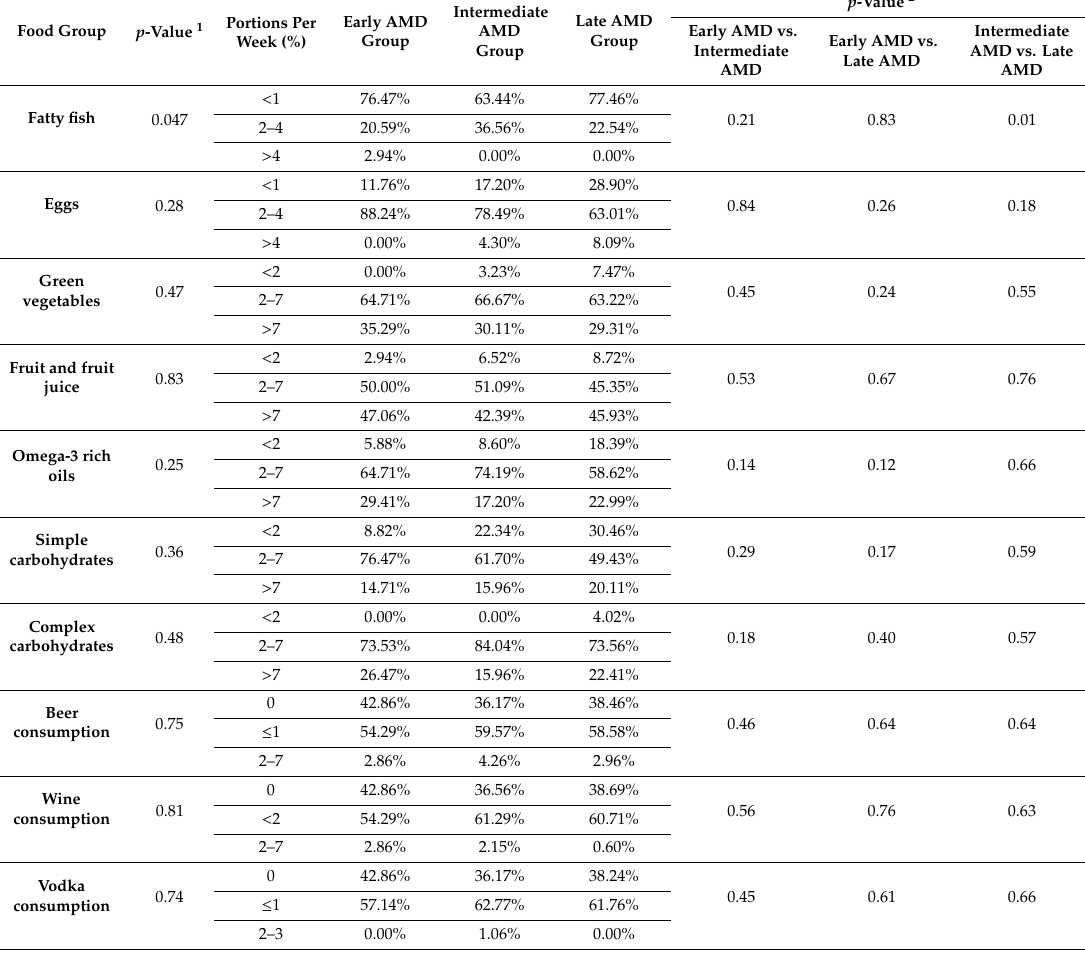
Table 3. Dietary habits of the early, intermediate and late AMD groups. The bold font indicates p -values < 0.05, which were considered statistically